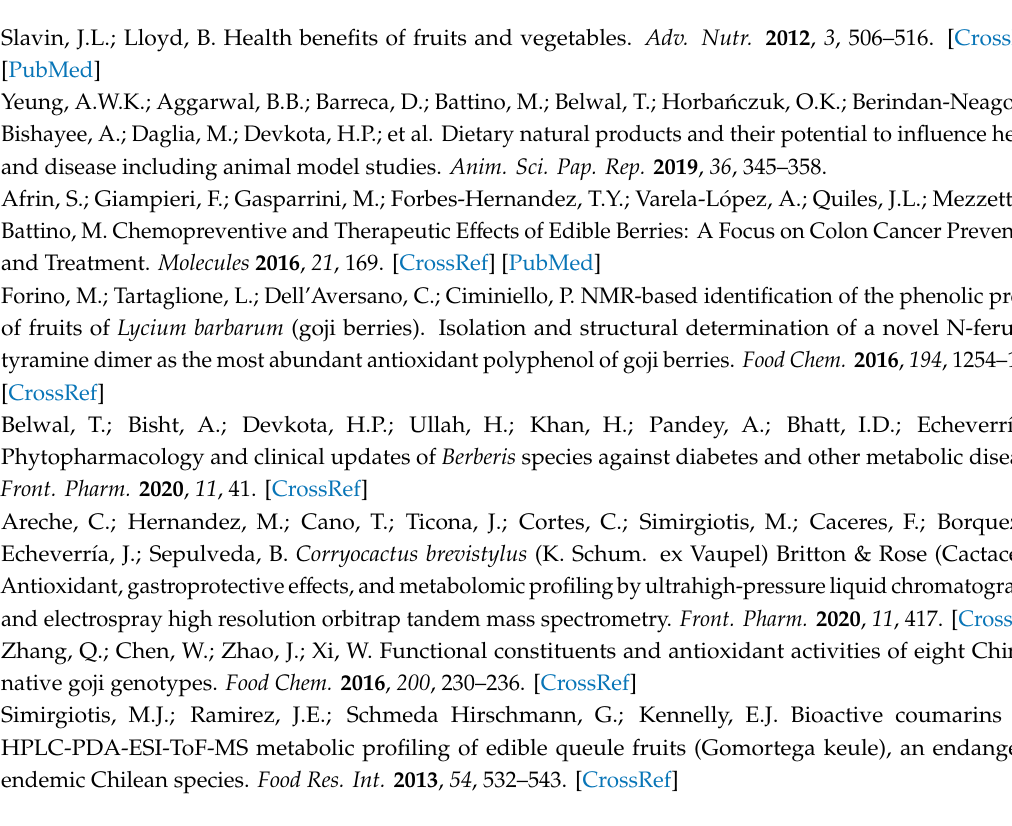
Supplementary Materials: The following are available online. Figure S1 (a–v): Full MS spectra and structures of compounds 1, 3, 7, 9, 12, 13, 15, 25, 27, 28, 29, 35, 37, 42, 43, 44, 46, 48, 51, 53, and 55; Table S1: Binding energies obtained from docking experiments of most abundant compounds in G. sphacelata ’s fruit and the known cholinesterase inhibitor galantamine over acetylcholinesterase ( Tc AChE) and butyrylcholinesterase ( h BuChE); Figure S2: Components of G. sphacelata fruits used in docking studies Figure S3: Predicted binding mode and predicted intermolecular interactions of all most abundant compounds in G. sphacelata pulp and seeds extracts and the residues of Torpedo californica acetylcholinesterase ( Tc AChE) catalytic site; Figure S4: Predicted binding mode and predicted intermolecular interactions of all most abundant compounds in G. sphacelata pulp and seeds extracts and the residues of human butyrylcholinesterase ( h BuChE) catalytic